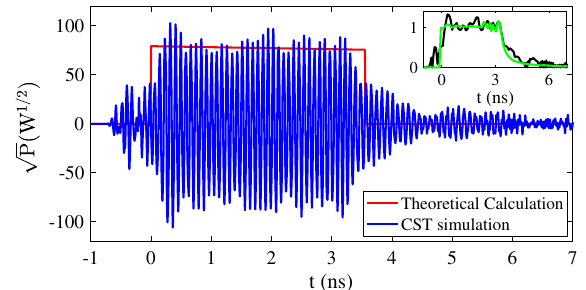
FIG. 6. Coupler output signal driven by a single bunch with ¼ 1 nC and σ ¼ 1 . 5 mm. The time, t ¼ 0 , is set at the start Q b z of the analytically calculated rf pulse from Eq. (12). Inset: Comparison of the normalized output signal amplitude when simulating the entire structure (black) and only the uniform section without the matching sections nor the rf coupler (green).